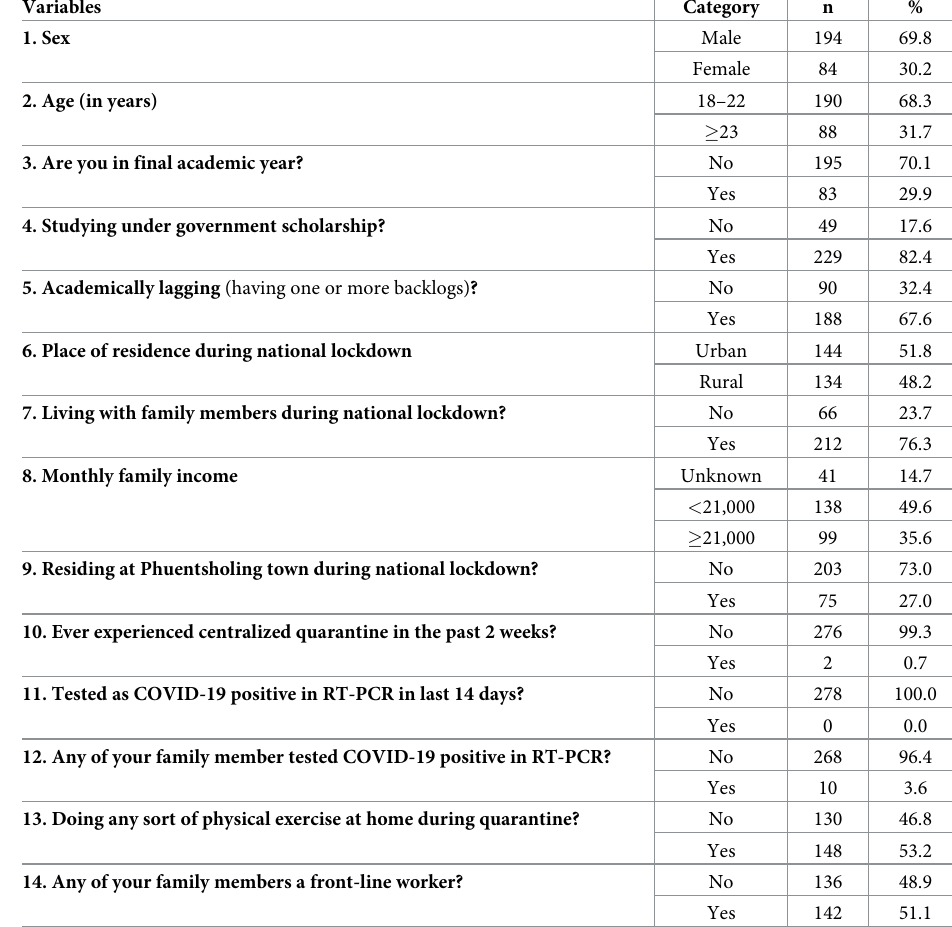
Table 1. Socio-demographic characteristics of students studying at college of science and technology (n = 278).